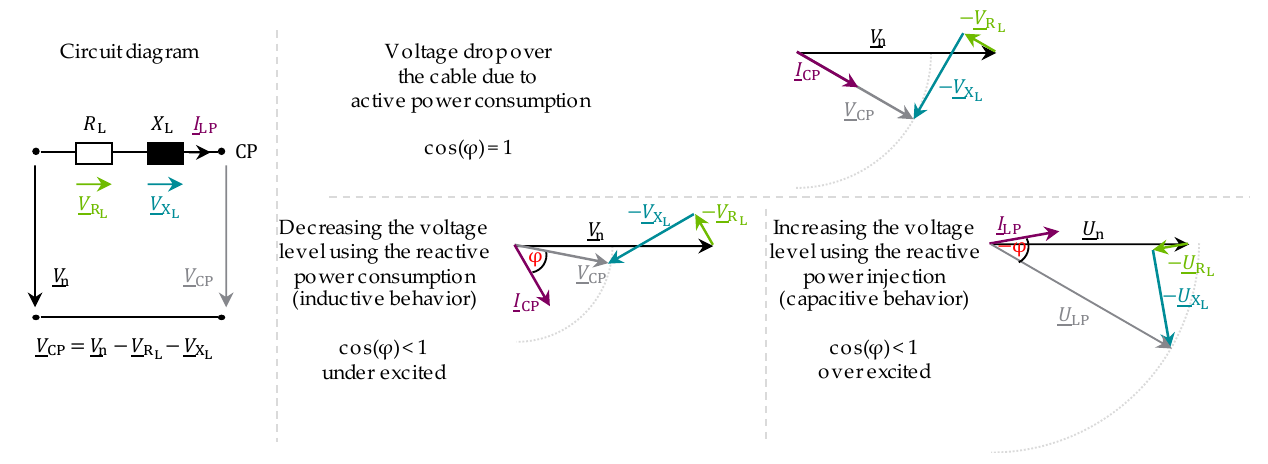
Figure 7. The principal operation of reactive power management based on [59].